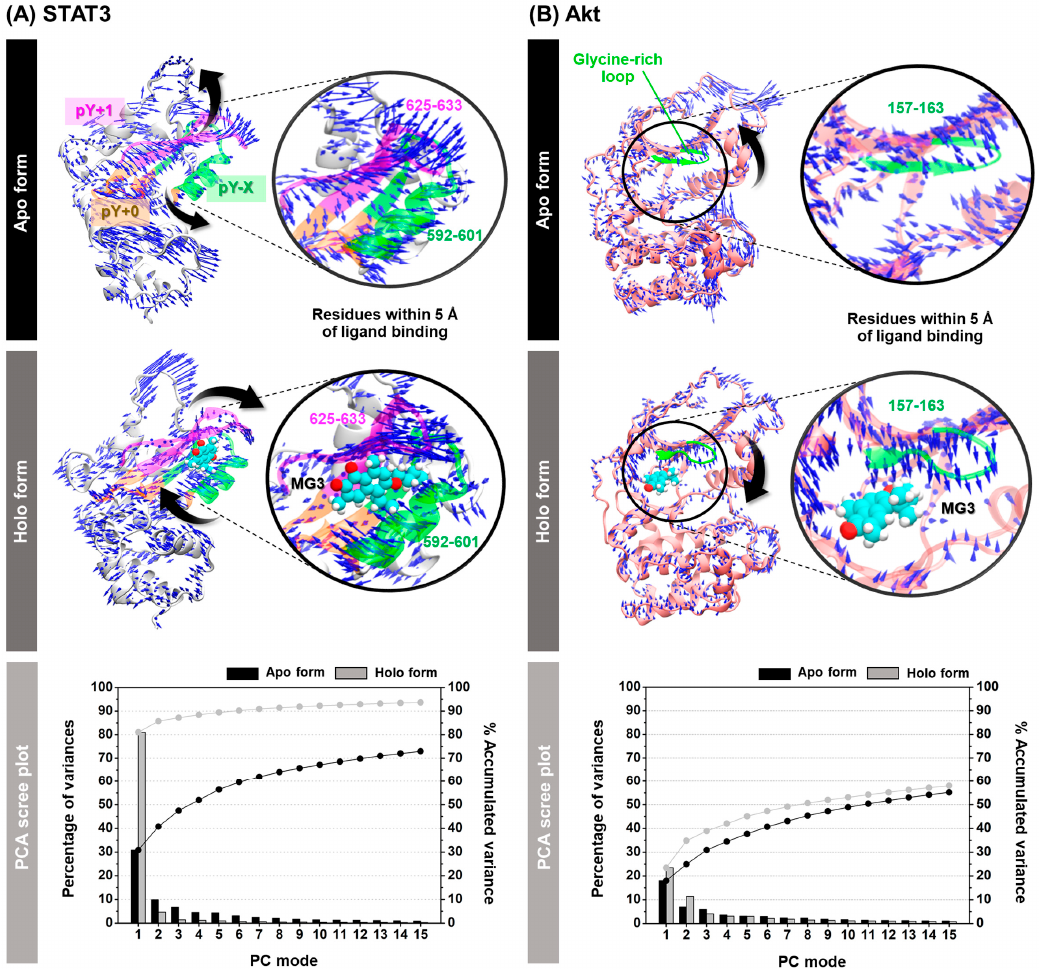
Figure 6. Porcupine plot of apo and holo forms of ( A ) STAT3 and ( B ) Akt across the PC1. The residues within 5 Å of ligand are presented in circle where the MG3 molecule is shown in vdW model. The PCA scree plot of quantitative characters for each protein is given below, in which the columns in black and grey represent the data for apo and holo forms, respectively.